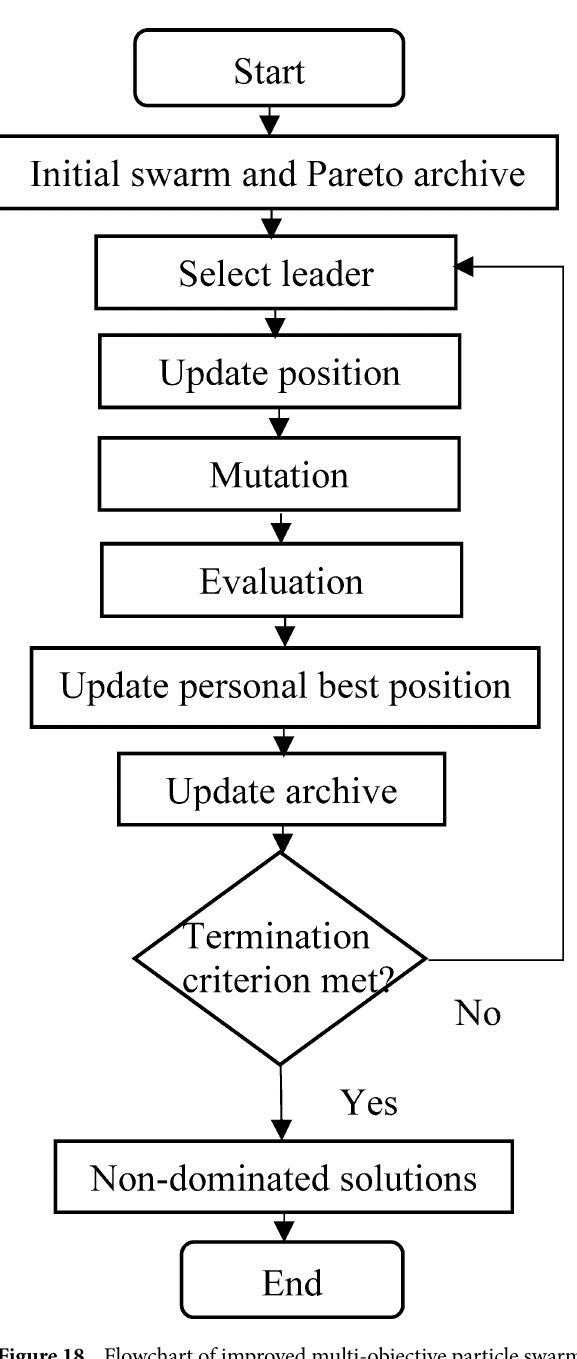
Figure 18. Flowchart of improved multi-objective particle swarm optimization algorithm (OMOPSO) to obtain non-dominated